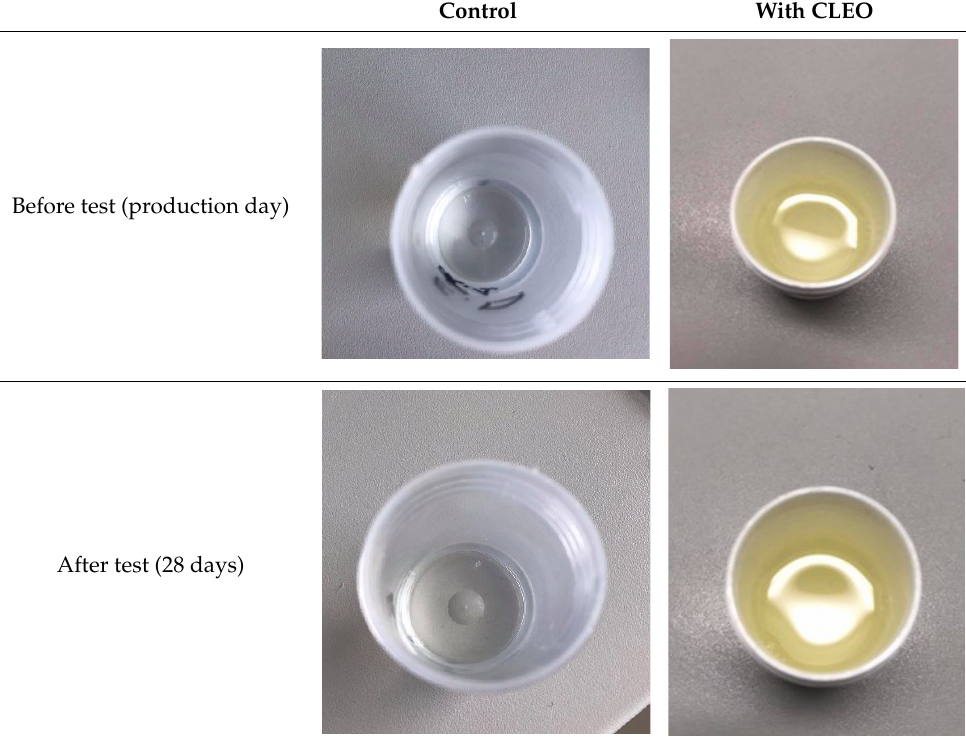
Before test (production day)